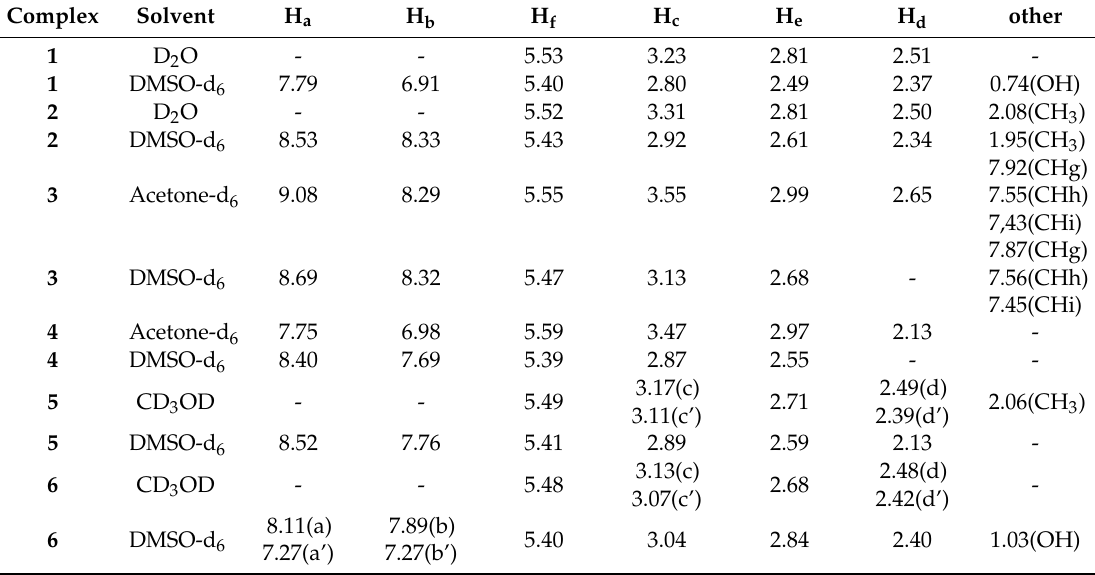
Table 1. 1 H-NMR chemical shifts (ppm) for complexes 1 – 6 in di ff erent deuterated solvents.